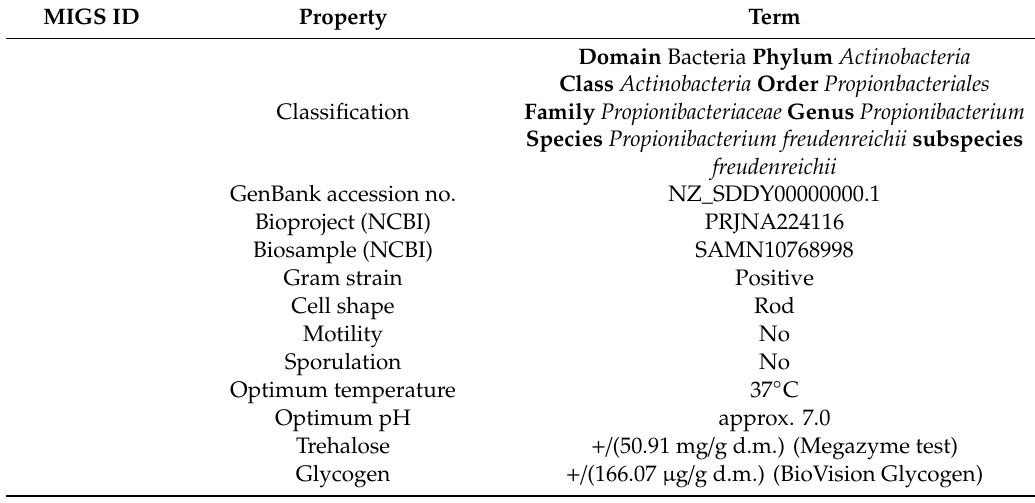
Table 1. Classification and general features of Propionibacterium freudenreichii subspecies freudenreichii T82 according to the MIGS recommendations (Minimum Information about a Genome Sequence)